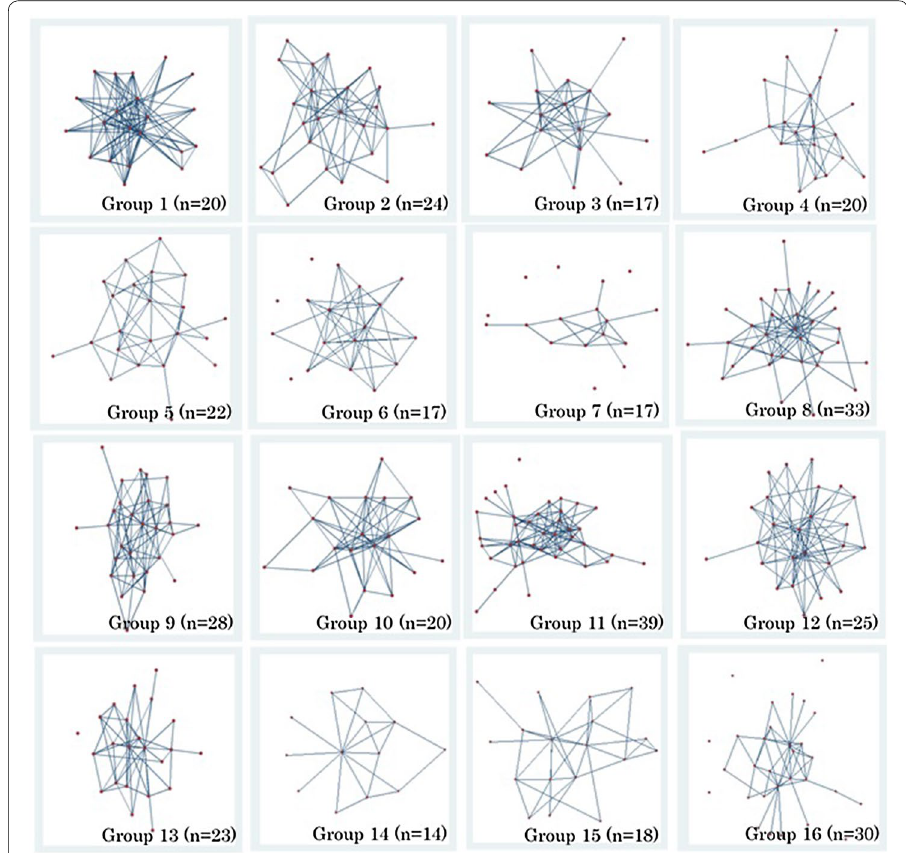
Fig. 2 Network structures of all farmers group (non-training participants